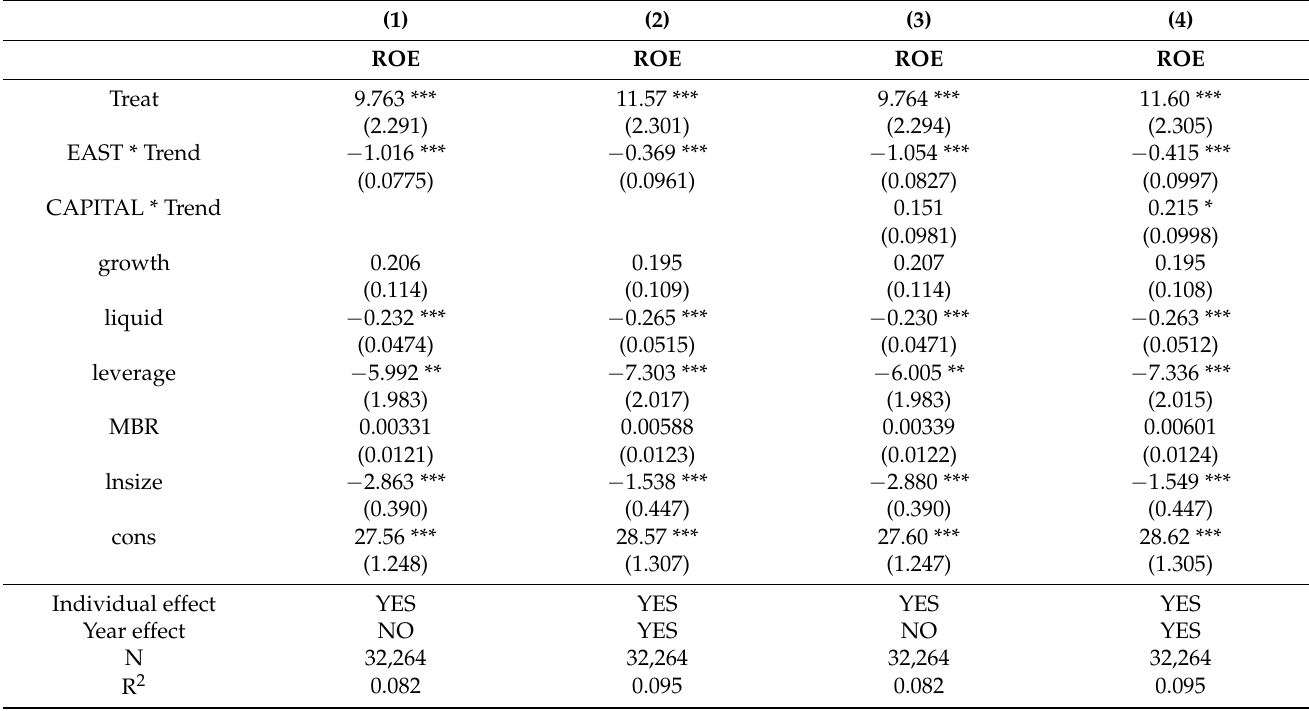
Figure 4. Results of Placebo test. Table 5. Regression results with benchmark